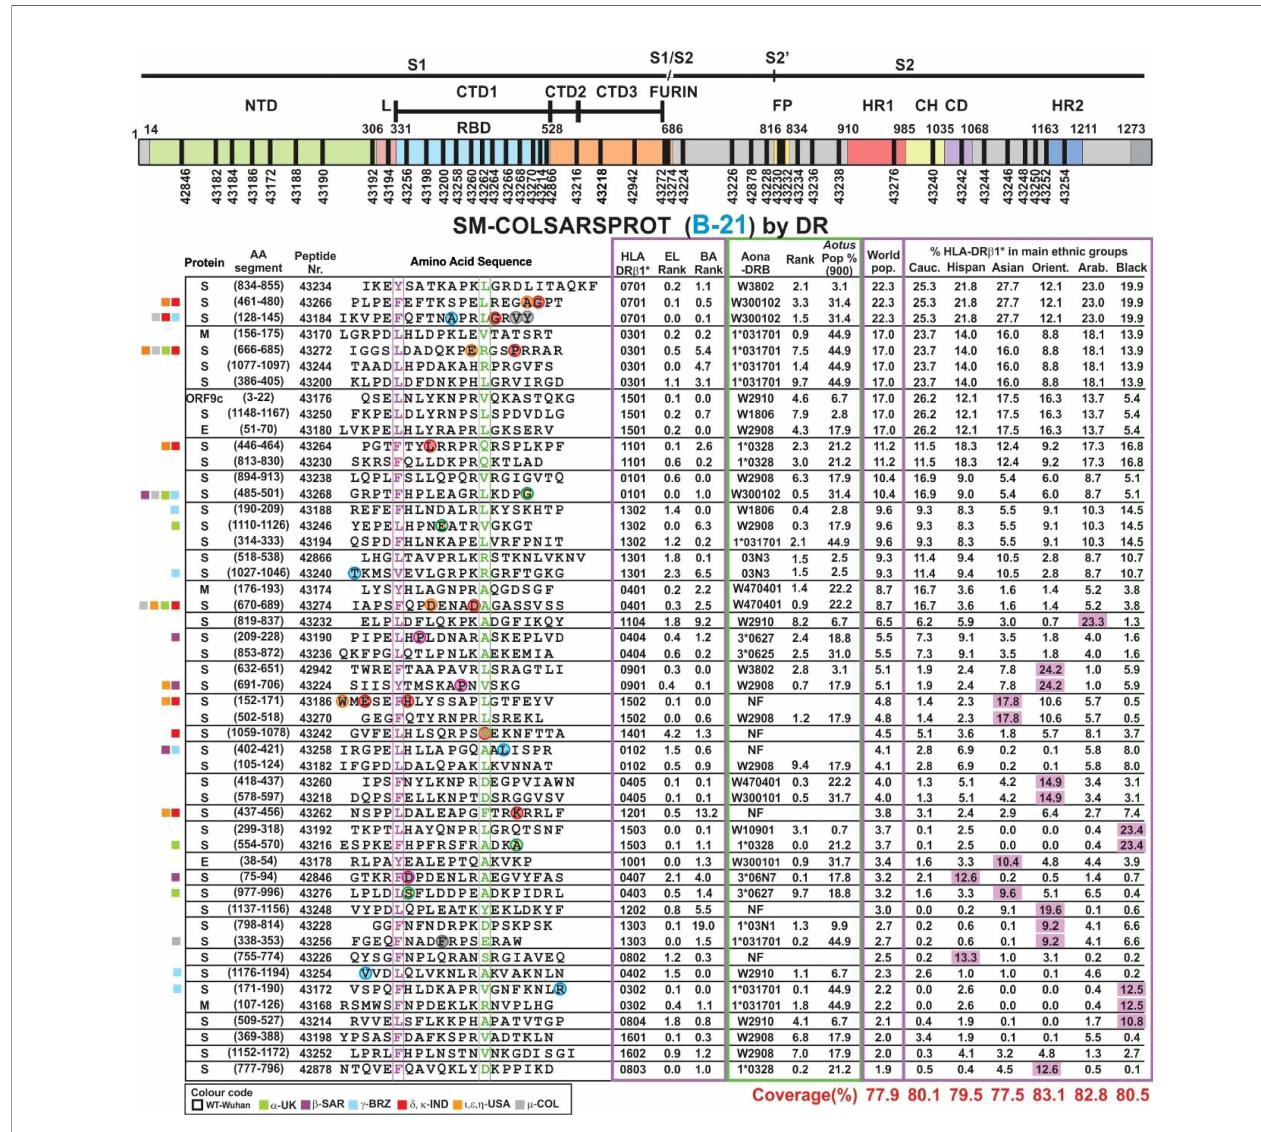
FIGURE 5 | SM-COLSARSPROT modi fi ed peptide aa sequences in B-21. Schematic representation of the S protein showing the modi fi ed peptides ’ location. Columns grouped according to the most frequently occurring HLA-DR b 1* alleles. Proteins: S, M, and E; aa segment, numbers in parenthesis show location in the aa sequence; peptide number: FIDIC serial number for modi fi ed peptides; their aa sequence boxed and highlighted in fuchsia and green residues fi tting into HLA-DR b 1* P1 and P9. Alpha mutant residues enclosed in green, beta in fuchsia, gamma in blue, and delta in red circles replaced in these peptides. Most frequently occurring HLA-DR b 1* alleles in the world ’ s population with their rank according to EL and BA binding ability. Aona-DRB alleles ranked according to EL and their frequency in the Aotus population. World population frequency (%) and these alleles ’ presence (%) in the main ethnic groups and Colombians. SM-COLSARSPROT potential world coverage and for the main ethnic groups at the bottom, highlighted in red. Fuchsia: alleles >3× frequency in target population. On the left, coloured squares according to VOC and VOI colour